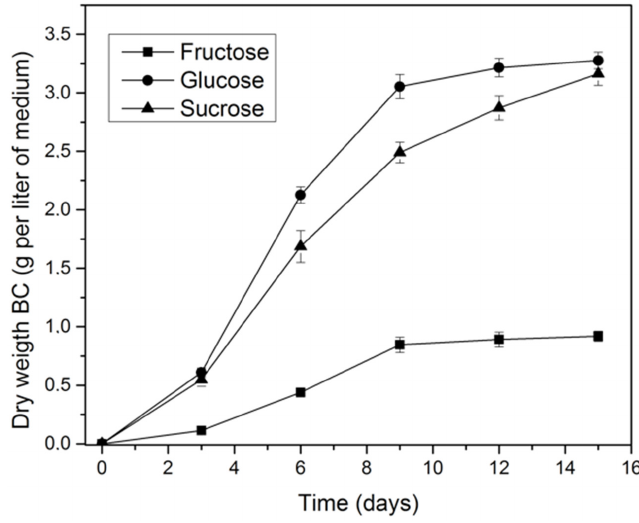
Figure 2. Bacterial cellulose produced by K. medellinesis in each culture medium with a substrate of 2%. For K. medellinensis, the highest yield of cellulose production (3.3 g/L) after 15 days was obtained